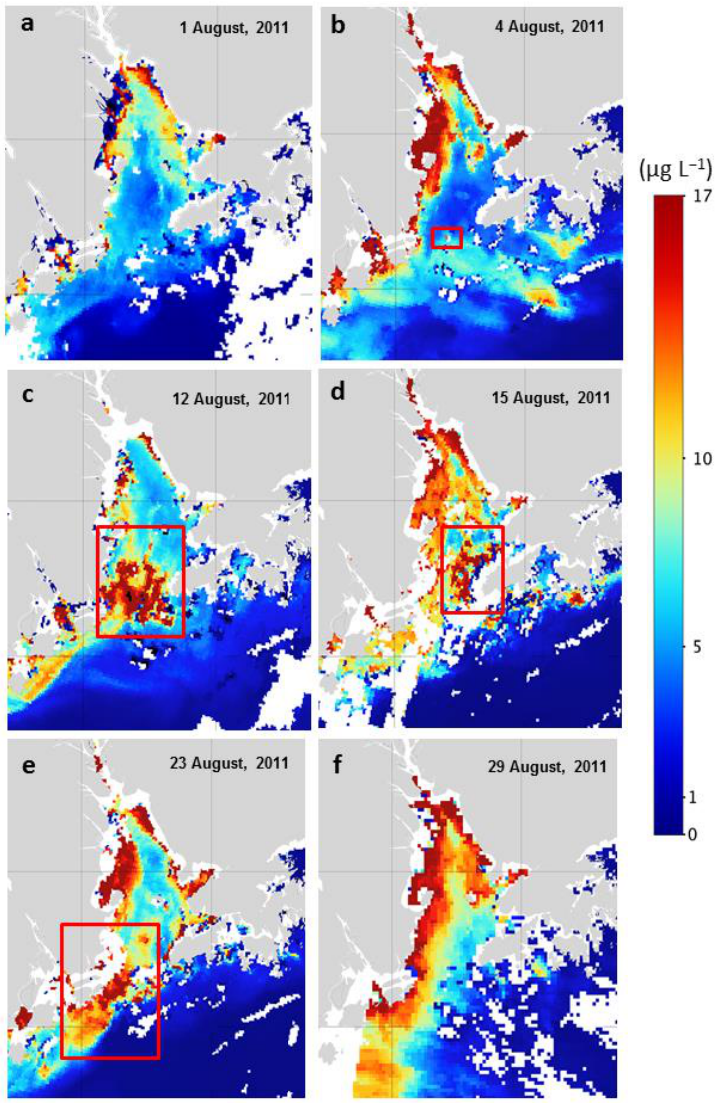
Figure 4. Comparison of chlorophyll ( µ g L −1 ) derived from the Medium-Resolution Imaging Spectrometer in the Pearl River Estuary, August 2011. Images obtained on ( a ) August 1 (before bloom), ( b ) August 4 (beginning of bloom), ( c ) August 12 (southerly winds during the bloom), ( d ) August 15 (southerly winds during the bloom), ( e ) August 23 (northerly winds during the bloom), and ( f ) August 29 (after bloom). High chlorophyll concentrations within red rectangles indicate Polykrikos geminatum bloom areas.